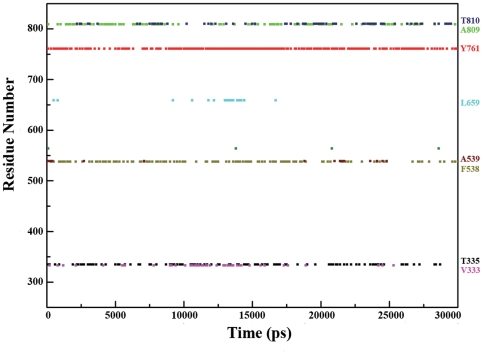
The residues involved in hydrophobic interactions with dimethylated H3K4 versus simulation time.Different colors are used for the sake of clarity.